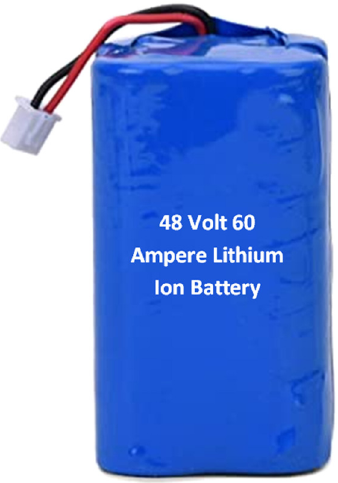
Figure 4: Lithium - ion battery pack.